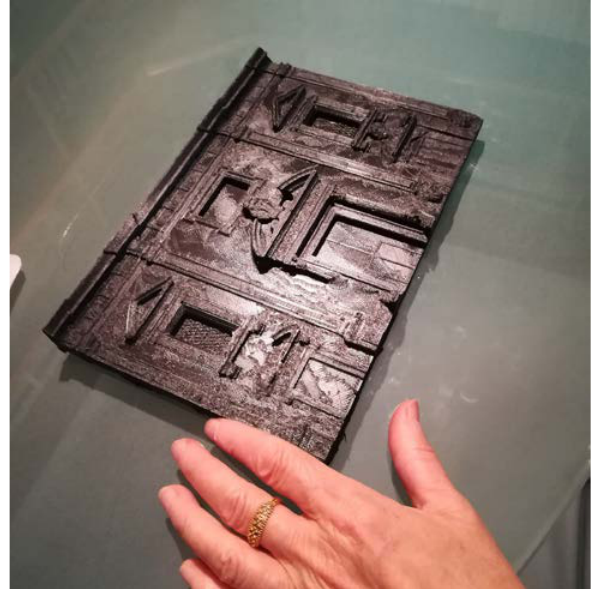
Figure 8. 3D printed model - experiment with a blind person